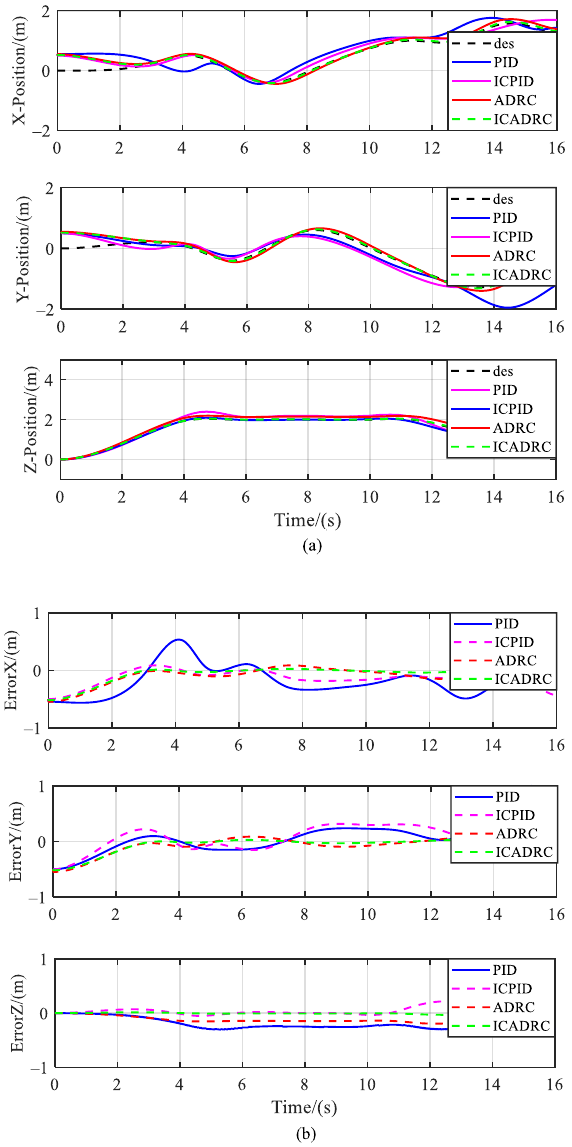
Figure 10. Trajectory decomposition curves. ( a ) The position trajectory tracking of the quadrotor under different controllers; and ( b ) the trajectory tracking errors of the quadrotor under different controllers.